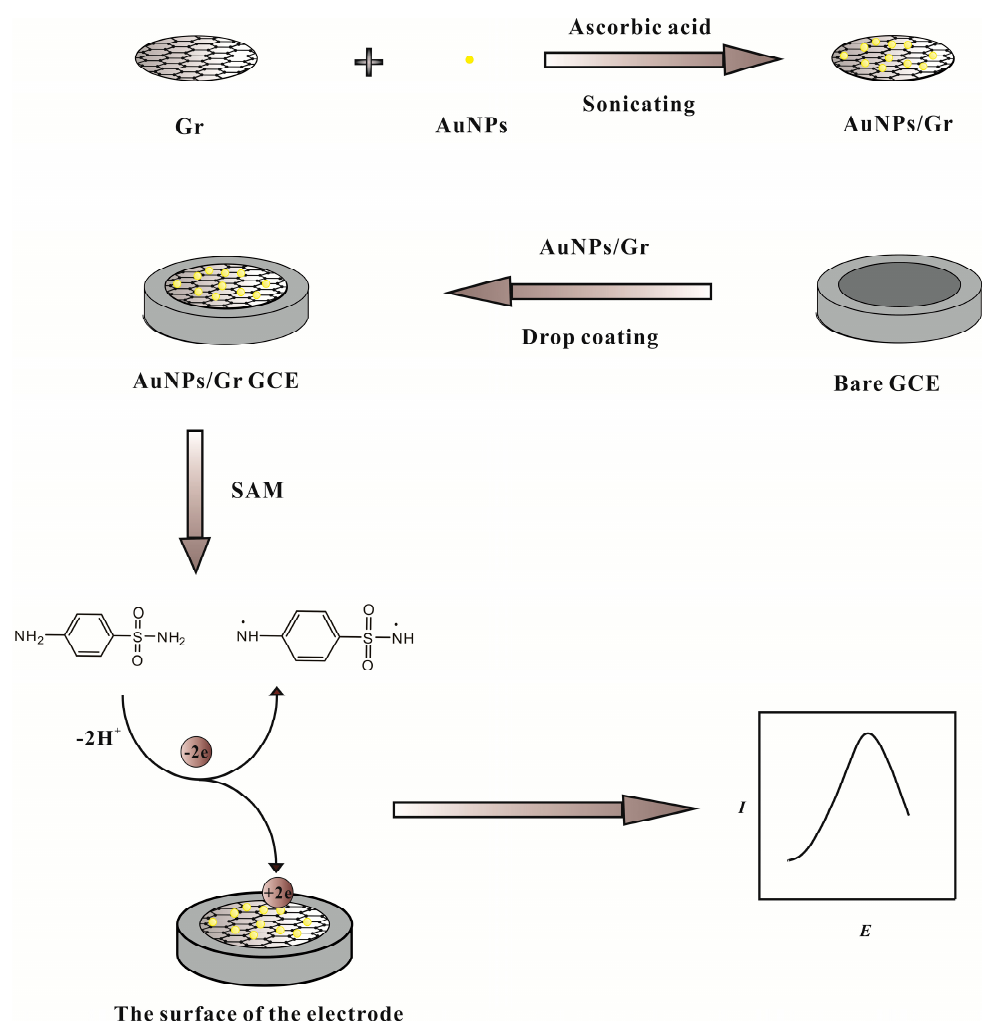
Scheme 1. Schematic diagram of the sulfanilamide sensor.